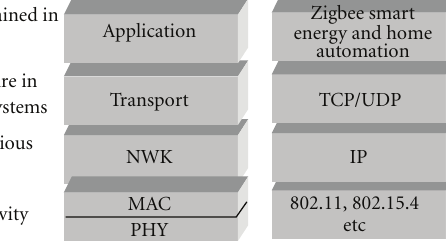
Figure 6: Interoperability